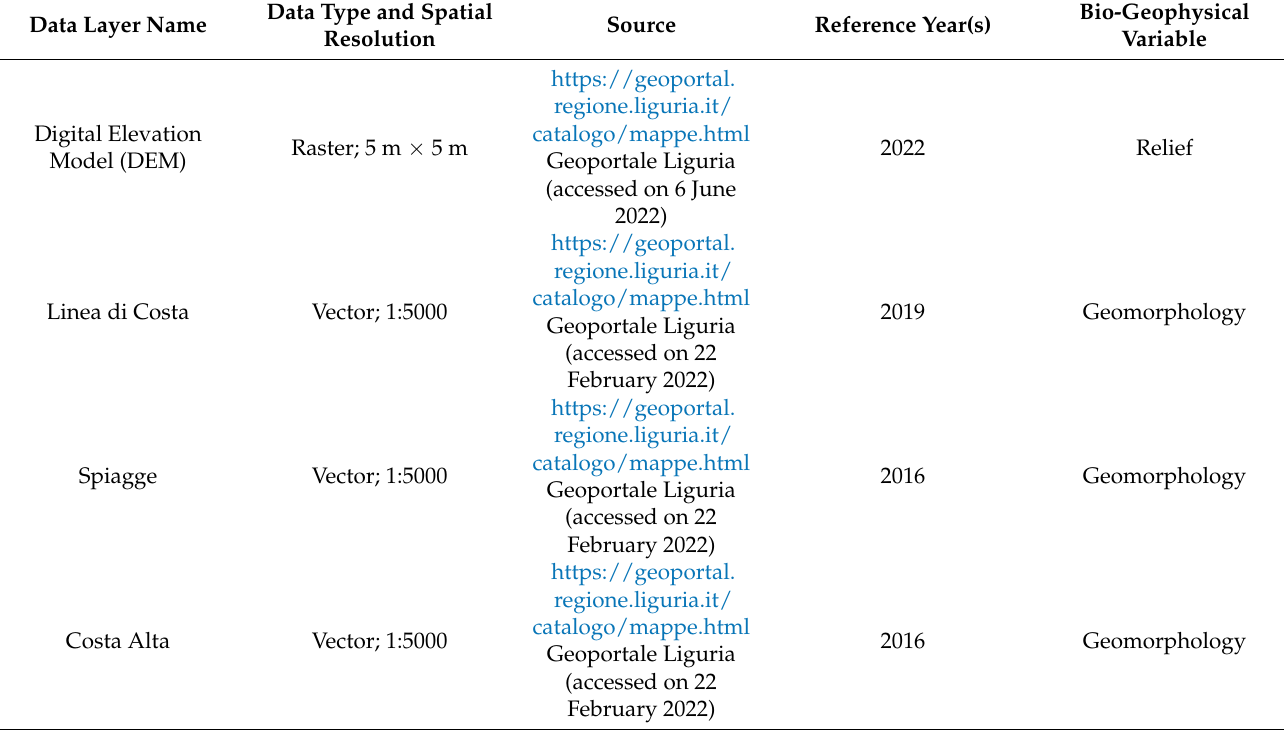
Table 1. Data inputs for the InVEST Coastal Vulnerability model